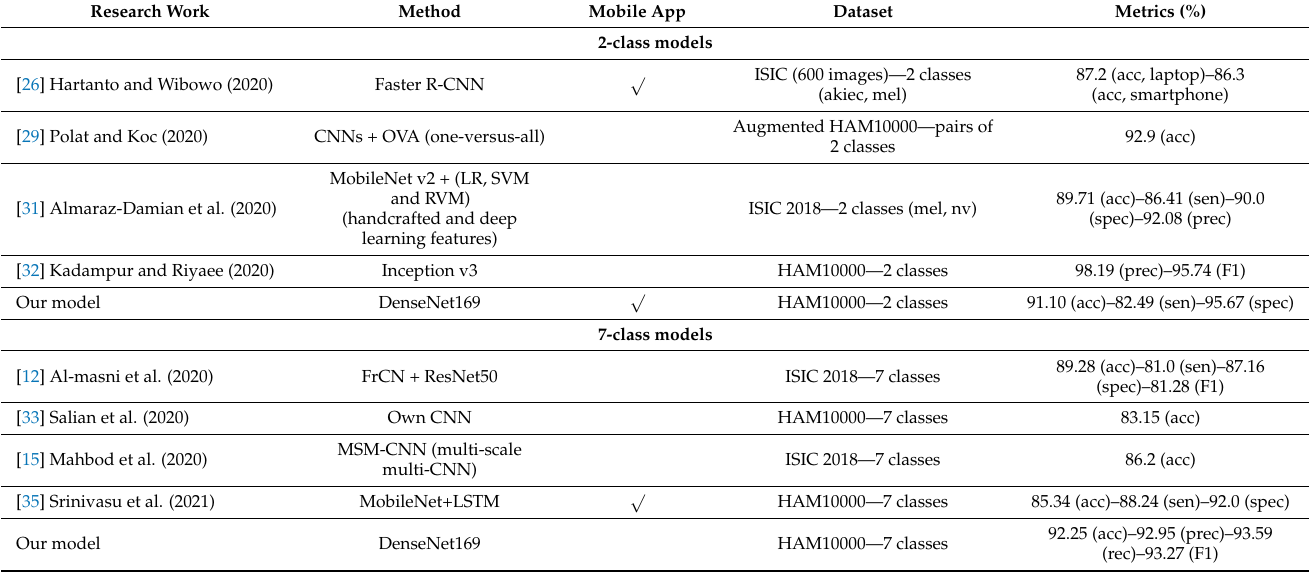
Table 6. Comparison of